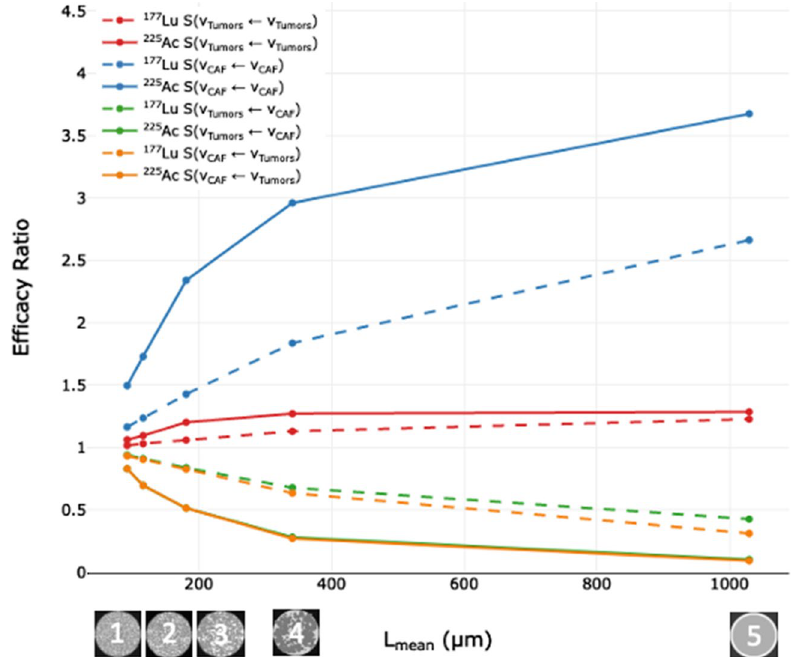
Fig. 8 Efficacy ratios (ERs) of the five models using either tumors and CAFs as sources or targets for 177 Lu and 225 Ac. Values for 225 Ac S(v Tumors ← v CAF ) and (v CAF ← v Tumors ) are